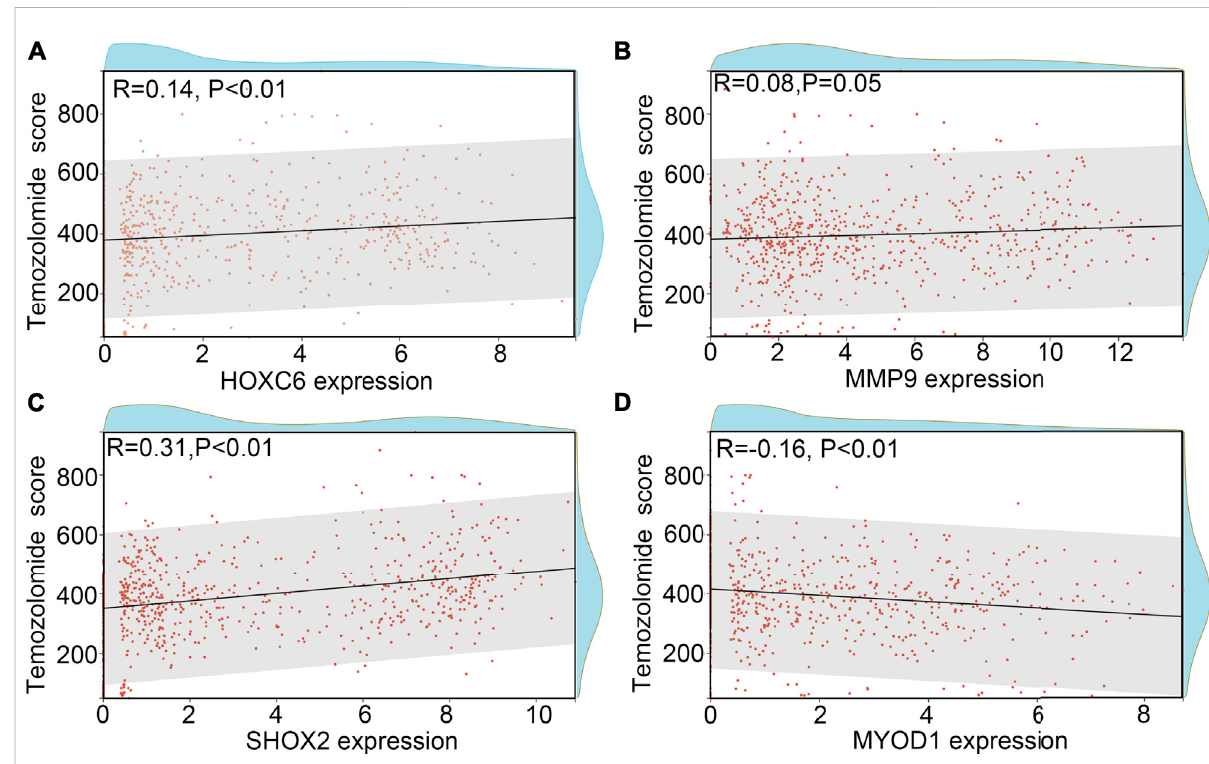
FIGURE 8 SHOX2wasassociatedwithTMZ-score. (A) RelationshipbetweenHOXC6andTMZ-score. (B) RelationshipbetweenMMP9andTMZ-score. (C) Relationship between SHOX2 and TMZ-score. (D) Relationship between MYOD1 and